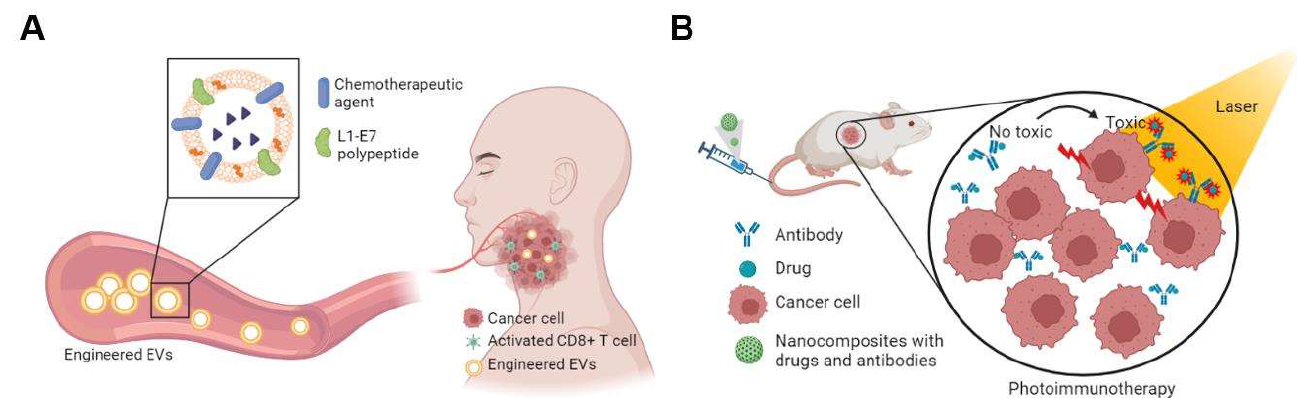
Figure 2. Application of extrasellar vesicles (EVs) in cancer vaccine ( A ) and nanocomposites in photoimmunotherapy ( B ).